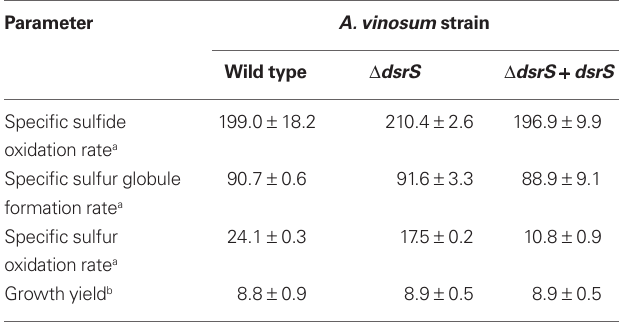
Table 6 | Characteristics of the A. vinosum ∆ dsrs deletion mutant compared to the wild type and the complementation mutant .